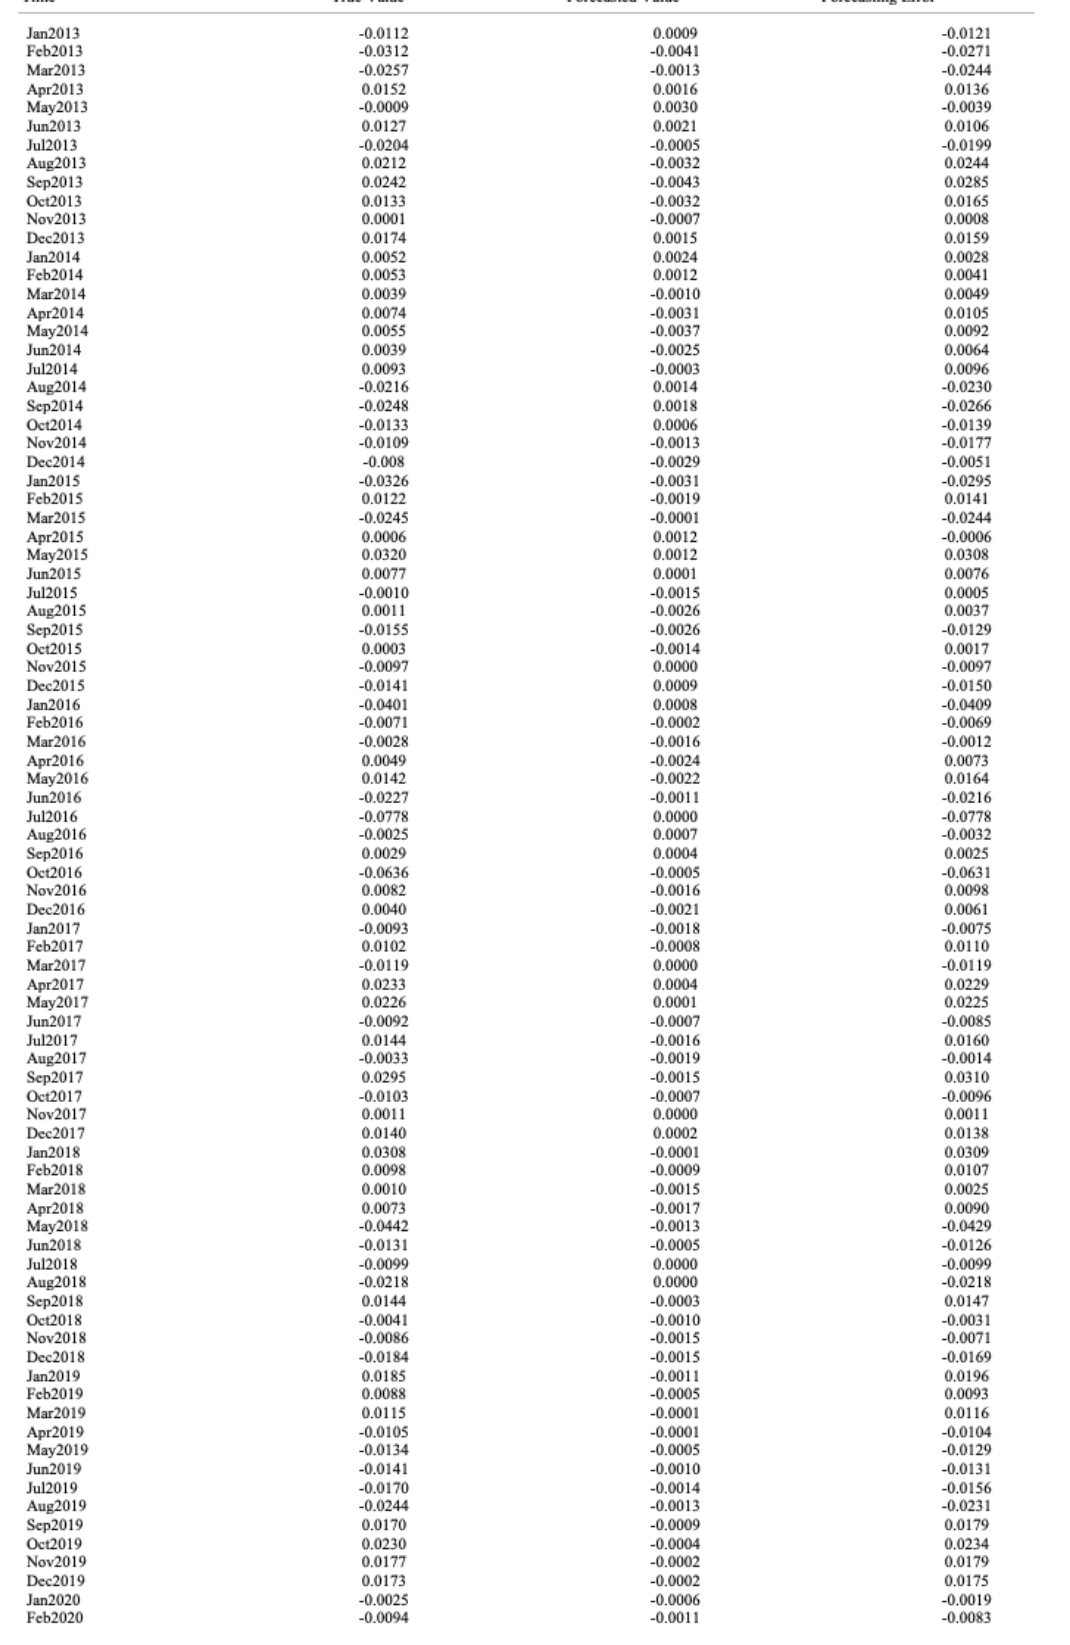
Table 6: Forecasting